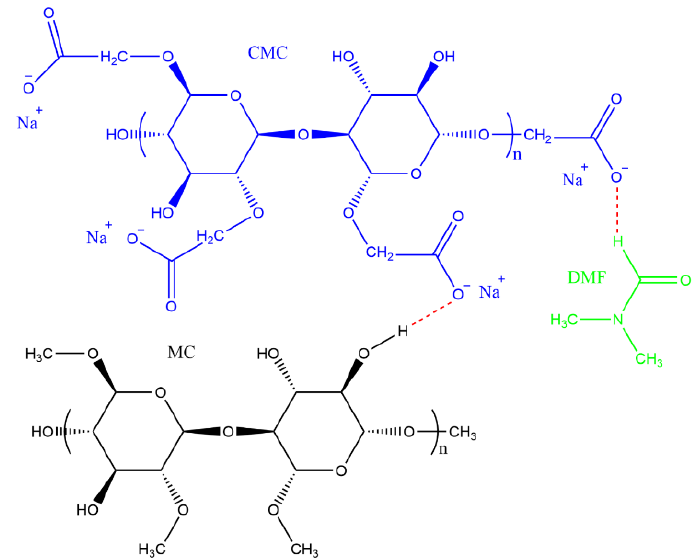
Figure A2. SEM micrograph of: ( a ) Pure CMC membrane; ( b ) pure MC membrane.